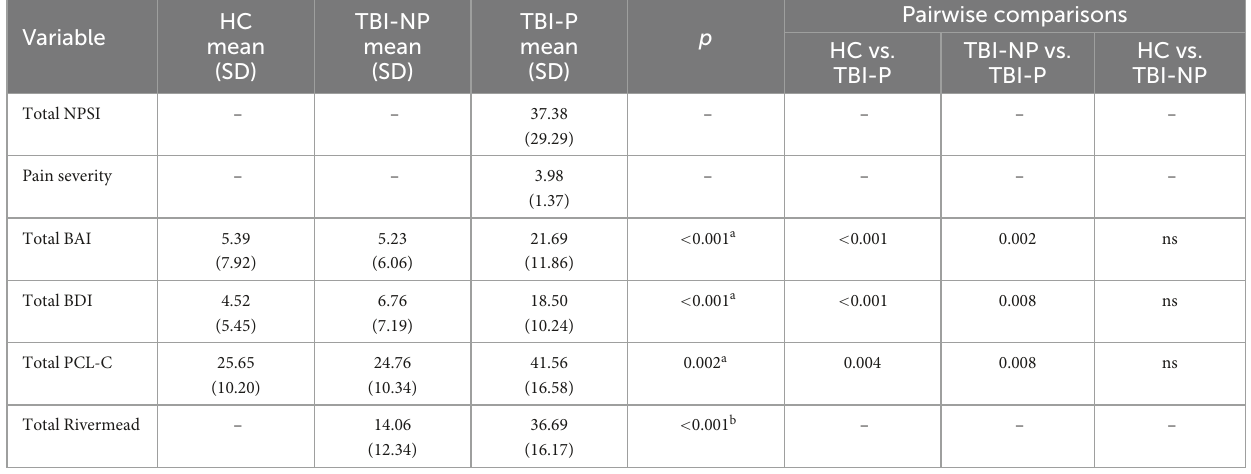
TABLE 2 Pain and psychological characteristics for the HC ( N = 31), TBI-NP ( N = 17), and TBI-P ( N = 16) groups.